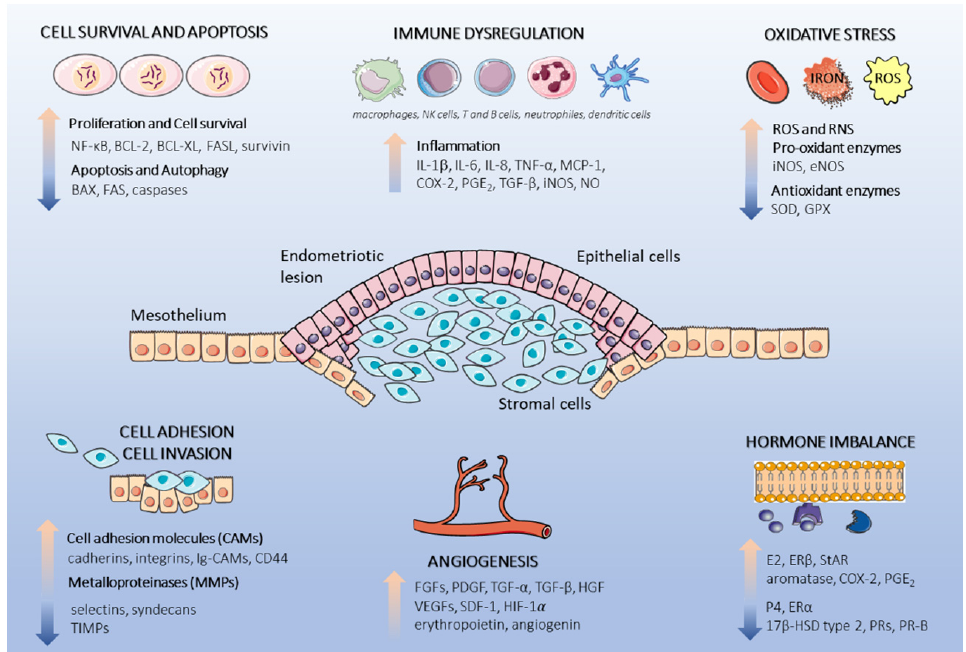
Figure 1. Schematic representation of dysregulated physiological processes in the endometriotic lesion. Endometriotic lesions consist of epithelial and stromal endometrial cells originating form retrograde menstruation. The endometrial cells subsequently attach to the underlying peritoneal mesothelium, proliferate, and initiate pro-endometriotic microenvironment formation. Cell prolifera- tion and resistance to apoptosis, cell adhesion, inflammation, oxidative stress, and hormone signaling are augmented by the interactions of multiple cells and secretion of cytokines, chemokines, and hormones, which facilitate endometriotic lesion progression. This figure was made using